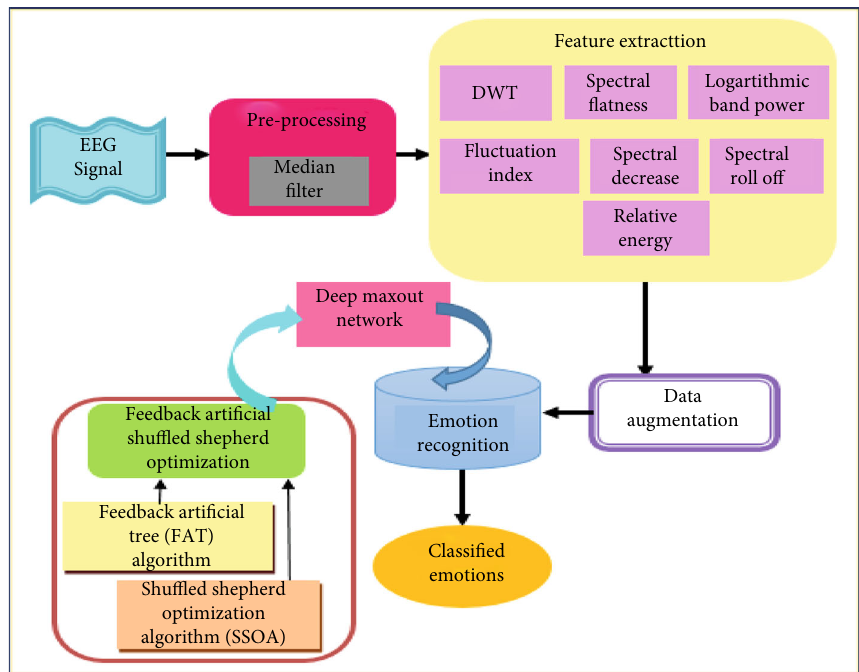
Figure 1: Block diagram of the proposed FASSO-driven deep maxout network for human emotion